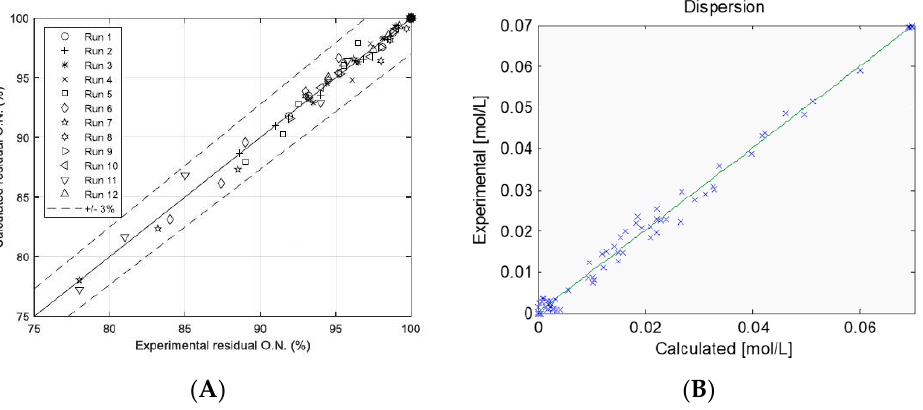
Figure 2. Parity plots for: ( A ) epoxidized soybean oil ring opening tests in the presence of sulfuric acid as catalyst [2]; ( B ) hydrogenation of trans, trans-muconic acid to bio-adipic acid promoted by Pd/C 5% (wt) [4].